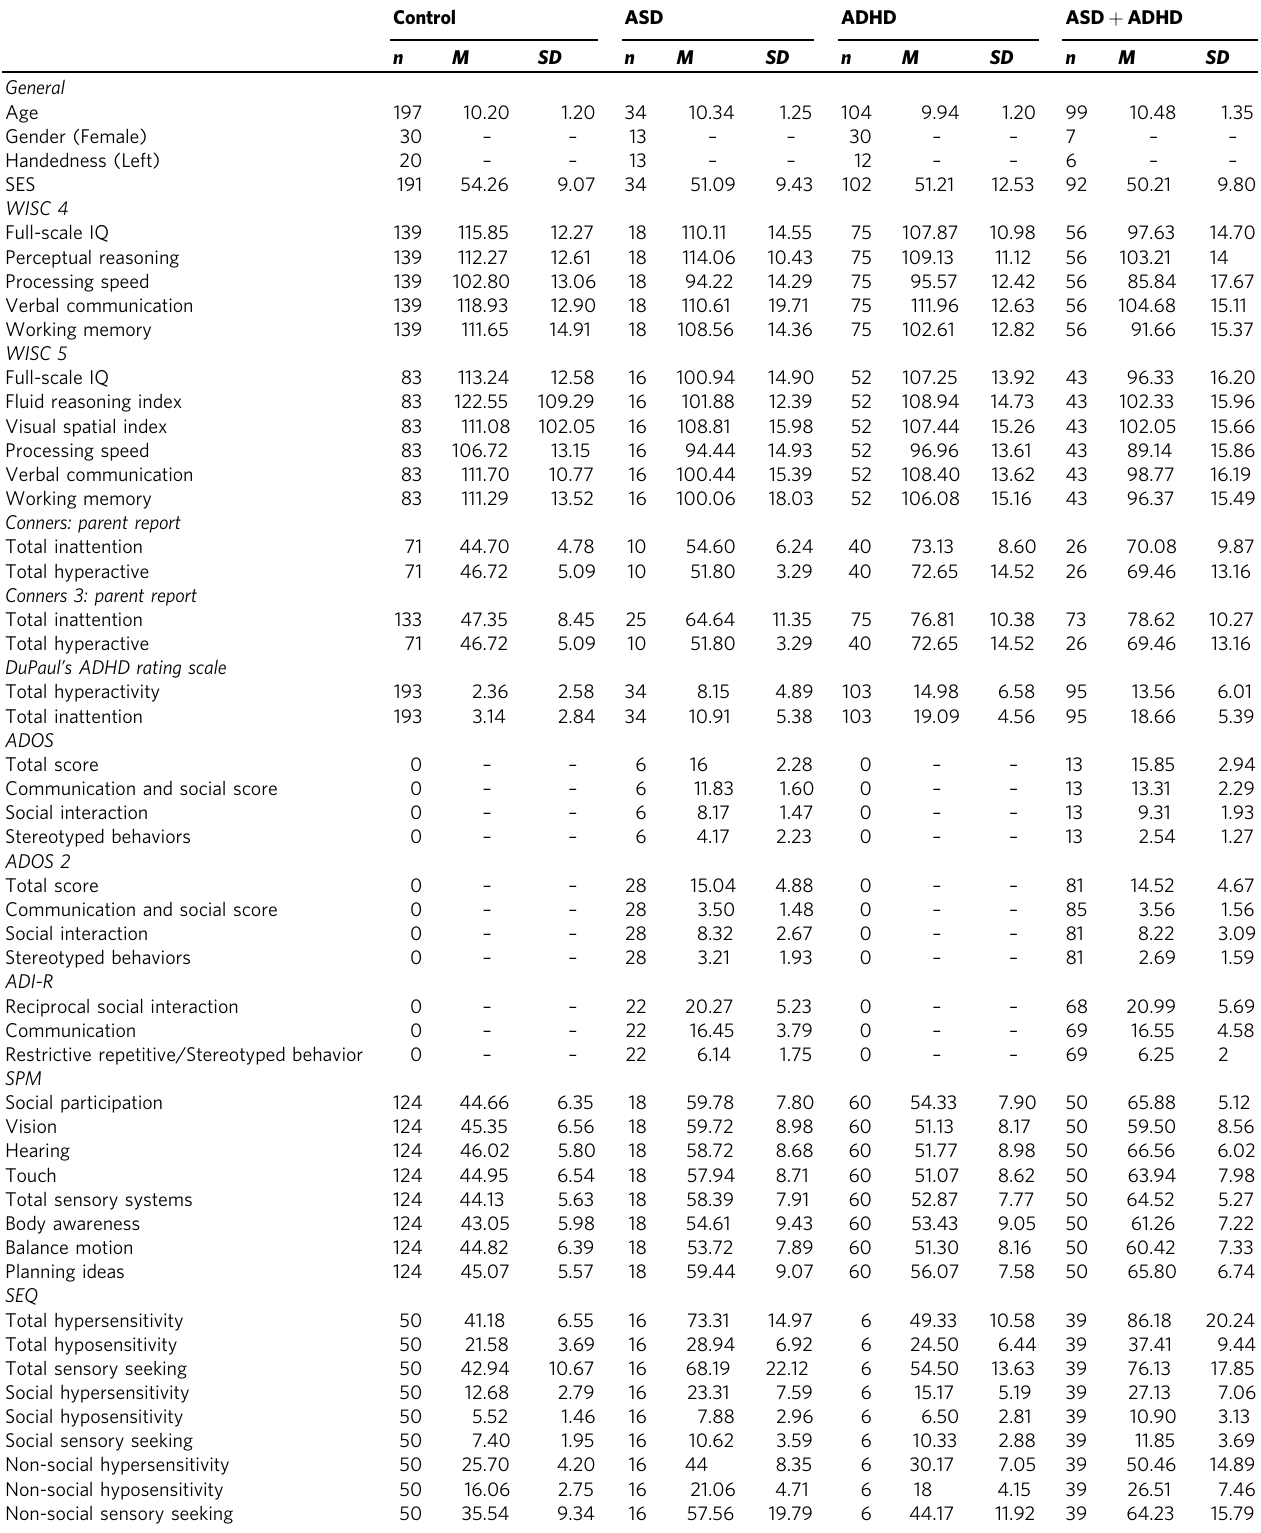
Table 1 Descriptive statistics for demographic based statistics by